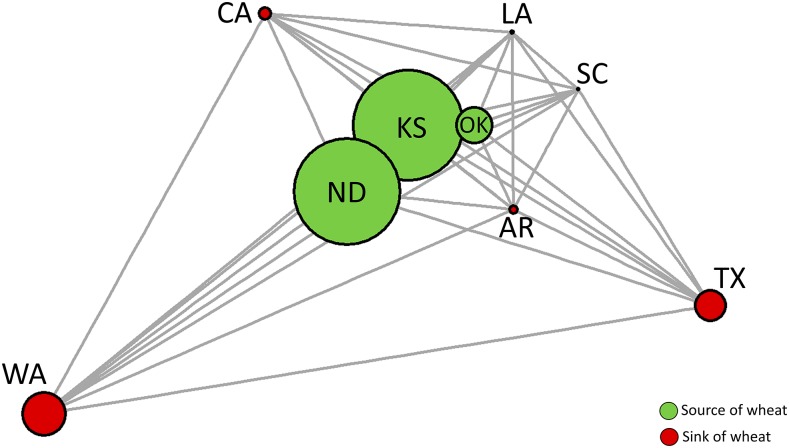
Network analysis of wheat producer and consumers. Network showing FST distance (links), wheat production (node size), and role as source (green) or sink (red) according to rail transport of wheat in the United States. Source locations are greater producers and tended be less isolated. Sink location are small producers and tented to be more isolated. KS, ND, OK are source populations of wheat whereas WA, CA, LA, SC, AR, TX are sink populations of wheat.